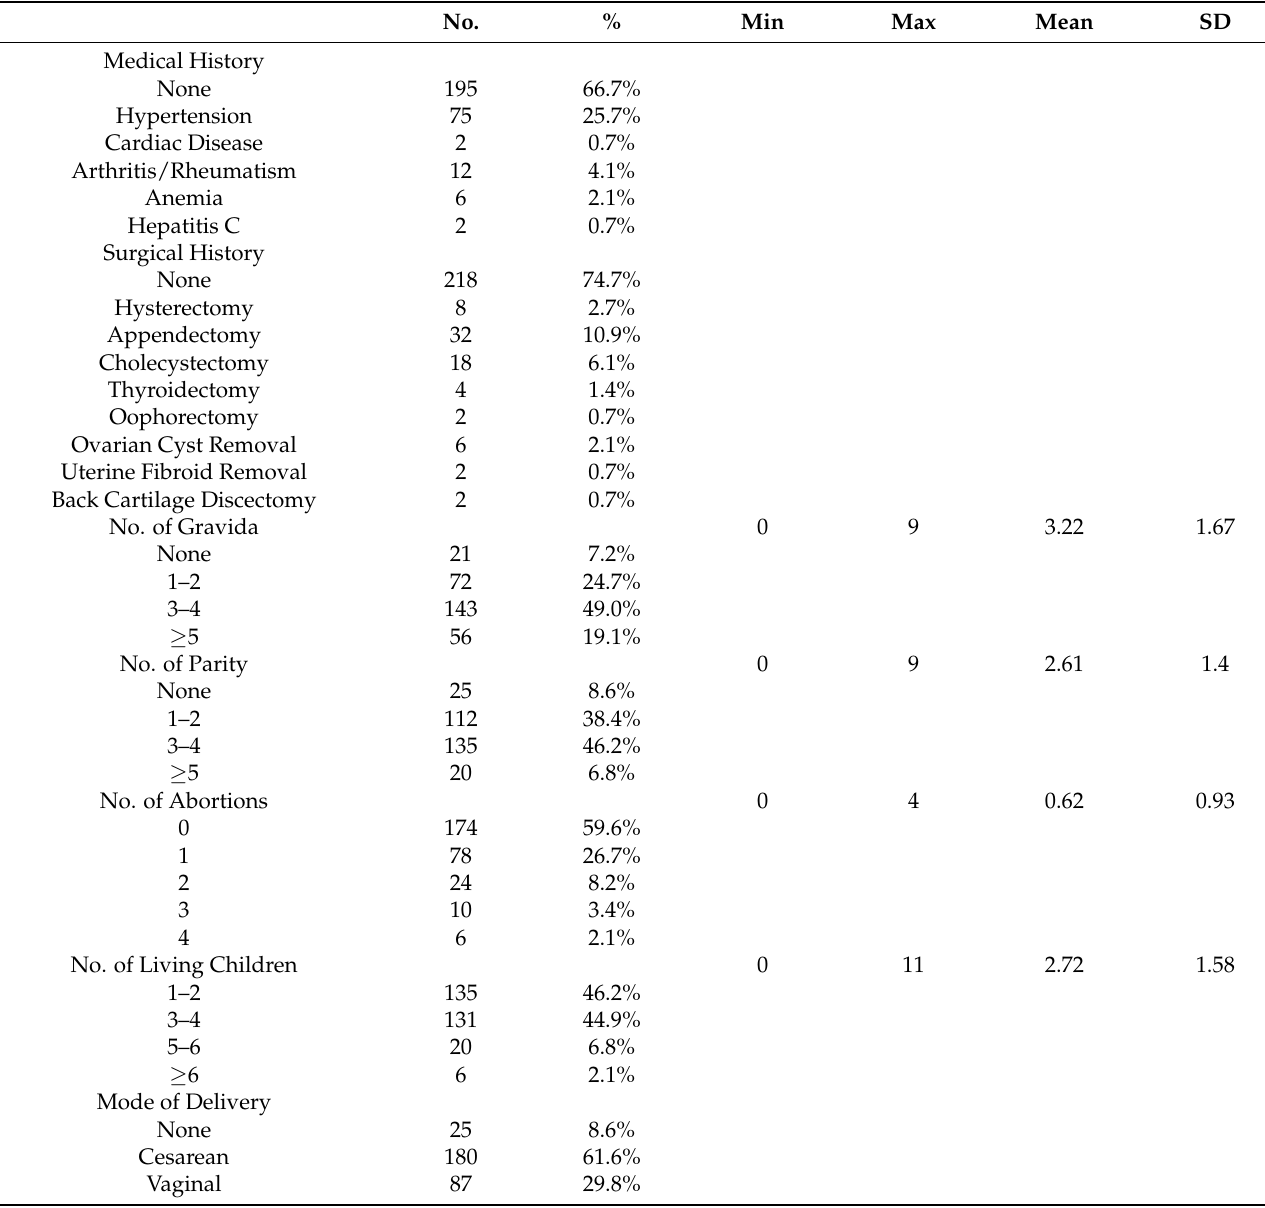
Table 2. Distribution of the subjects according to their medical, surgical, and obstetric